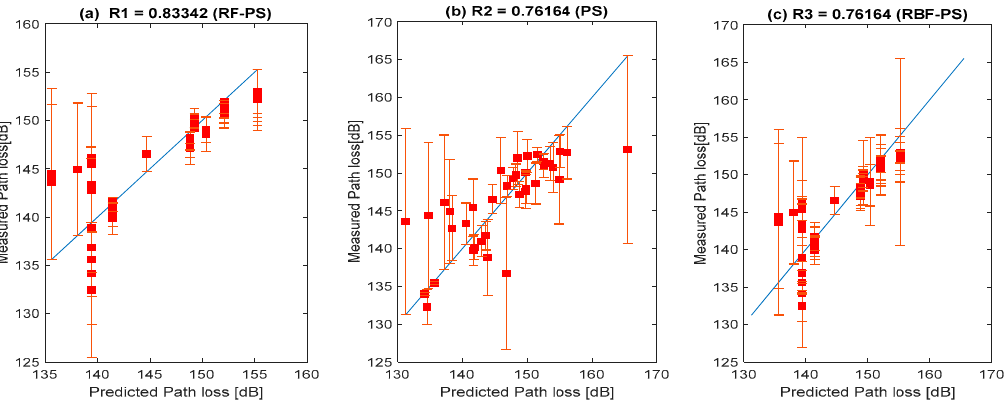
Figure 23. Results showing the correlation between the measured path loss and predicted path loss using the hybrid RF-PS prediction method and two existing standard path loss prediction methods in site 1 of location 2.